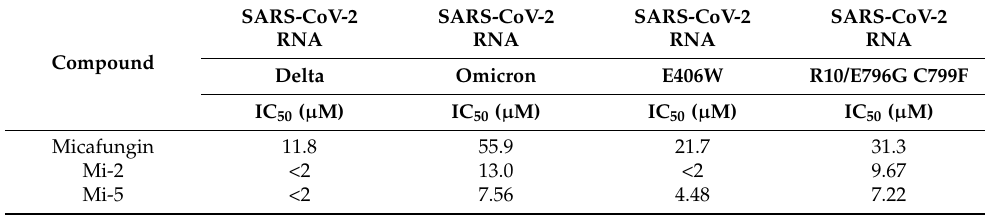
Table 2. The IC 50 against SARS-CoV-2